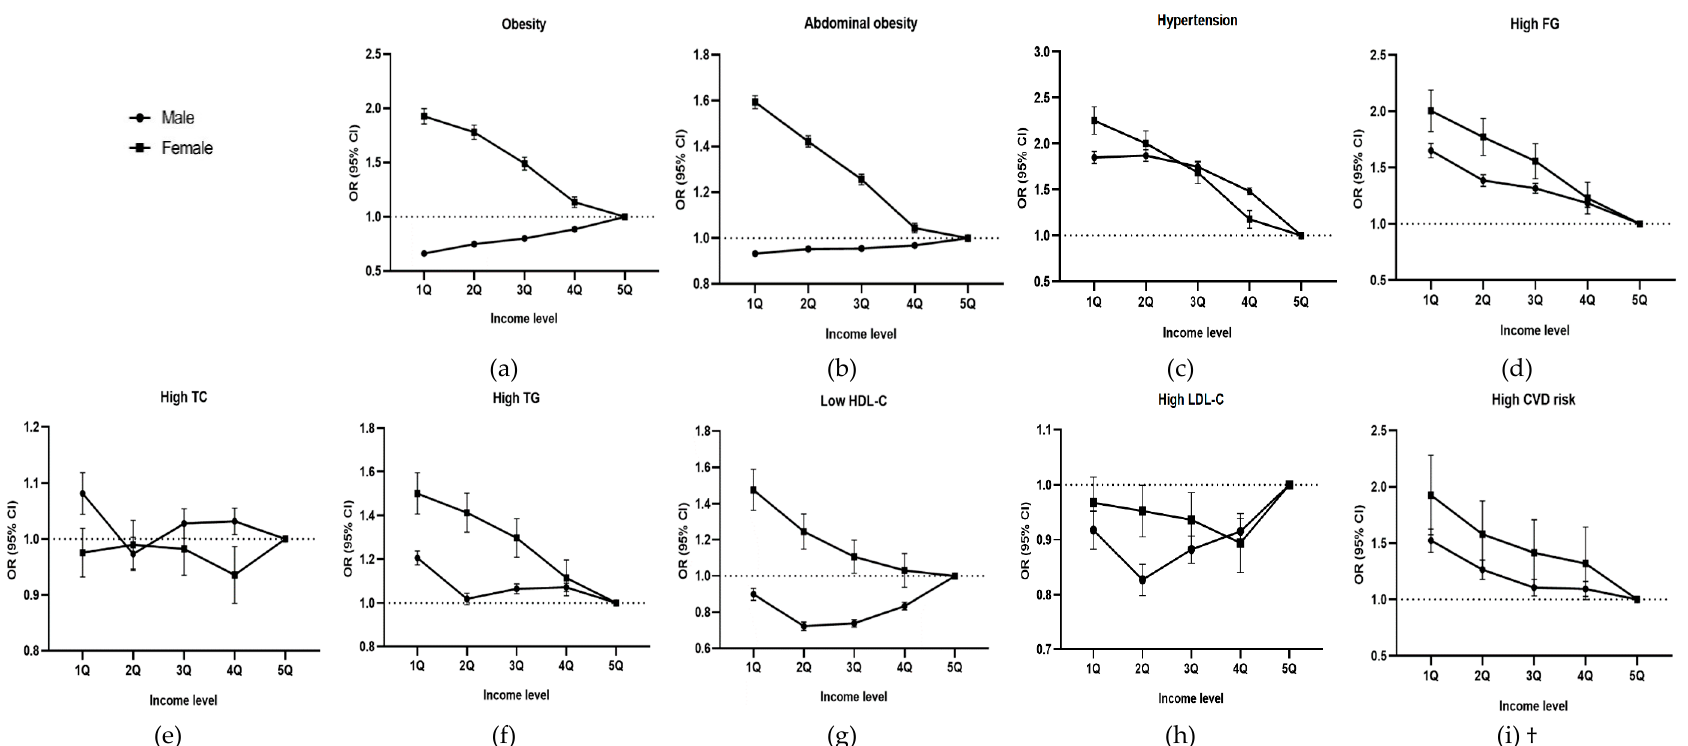
Figure 2. Odds Ratio (OR) of CVD-related health status by income level: ( a ) OR of obesity by income level, ( b ) OR of central obesity by income level, ( c ) OR of hypertension by income level, ( d ) OR of high FG by income level, ( e ) OR of high TC by income level, ( f ) OR of high TG by income level, ( g ) OR of Low HDL-C by income level, ( h ) OR of high LDL-C by income level, and ( i ) OR of high CVD risk by income level. † CVD risk only includes persons older than 30 years and excludes the 58,308 subjects with either a related medical history or currently taking medicines related to CVDs, such as stroke and heart disease. Adjusted for age, region, smoking, alcohol consumption, and frequency of walking, moderate exercise, and vigorous exercise. Abbreviations: OR, odds ratio; CI, confidence interval; Q, Quintile; FG, fasting glucose; TC, total cholesterol; TG, triglyceride; HDL-C, high-density lipoprotein-cholesterol; LDL-C, low-density lipoprotein-cholesterol; CVD, cardiovascular disease. Error bars indicate 95% CI.